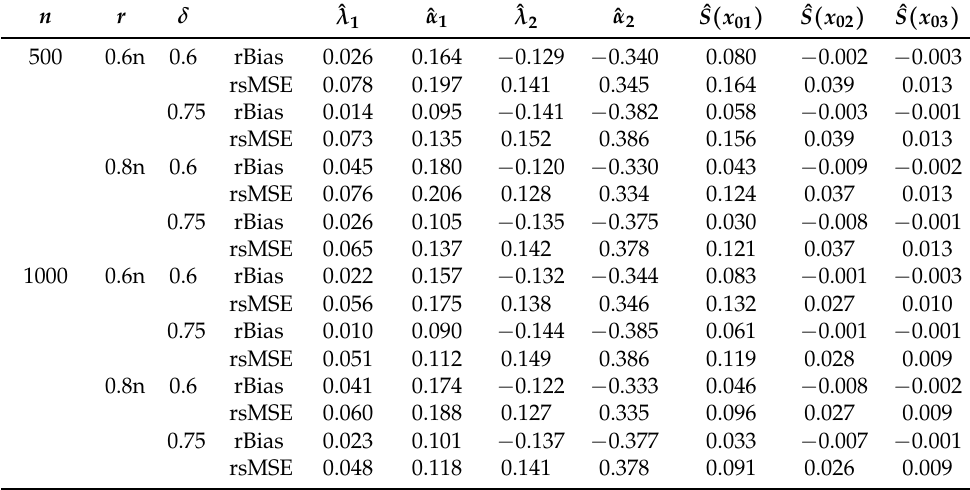
Table 2. Mixture GE distributions model with λ 1 = 1.5, α 1 = 2, λ 2 = 2, α 2 = 4